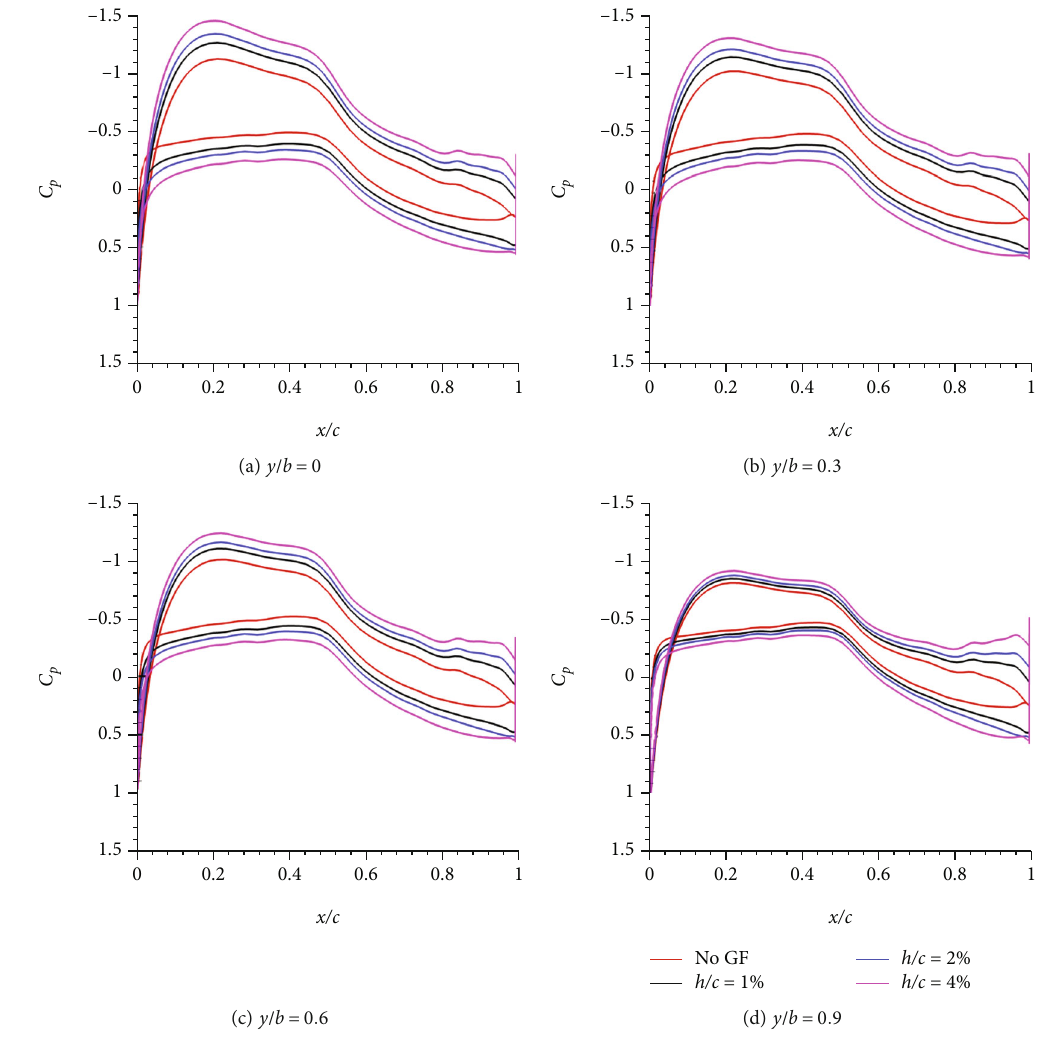
Figure 10: Pressure coe ffi cient distributions on di ff erent spanwise locations at α = 0 ° . Table 2: Aerodynamic performance parameters of tiltrotor wing without and with a